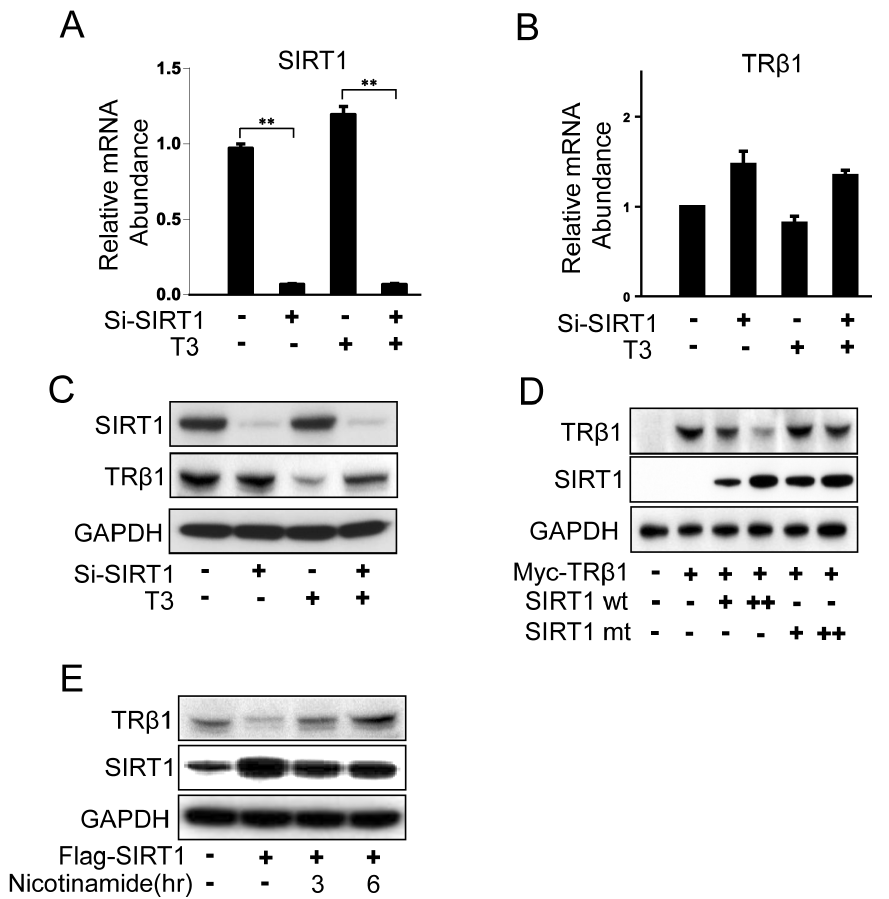
Figure 4. SIRT1 knockdown reverses hormone-dependent reduction of TR b 1 steady state levels. (A, B) qPCR analysis of endogenous SIRT1 mRNA and TR b 1 mRNA in HepG2-TR b 1 cells + / 2 transfection of SIRT1 siRNA. All data are representative of at least three independent experiments with similar results. All values represent the mean 6 SD of duplicate samples. **, P , 0.01. ( C ) Western analysis of SIRT1 and TR b 1 protein levels in HepG2-TR b 1 cells + / 2 SIRT1 siRNA. Note that SIRT1 levels were strongly inhibited by SIRT1 siRNA treatment and that TR b 1 levels were unaffected in the absence of ligand, but that SIRT1 reversed T 3 -dependent reductions in TR b 1 protein levels. The lower panel represents GAPDH loading control for Western blot analyses. ( D ) SIRT1-dependent reduction of TR b 1 protein levels requires SIRT1 deacetylase activity. Western analysis of 293T cells transfected with TR b 1 + / 2 wild type or mutant (H355Y) SIRT1 expression vectors and treated with T 3 . ( E ) T 3 -dependent reductions in TR b 1 protein levels were reversed by nicotinamide. Panels show western analysis of HepG2-TR b 1 cell extracts transfected + / 2 SIRT1 expression vector and treated with T 3 for 24hrs and 10 mM nicotinamide for indicated times. Note the recovery in TR b 1 levels after nicotinamide treatment. The lowest panel represents a western blot with anti-GAPDH antibody as loading